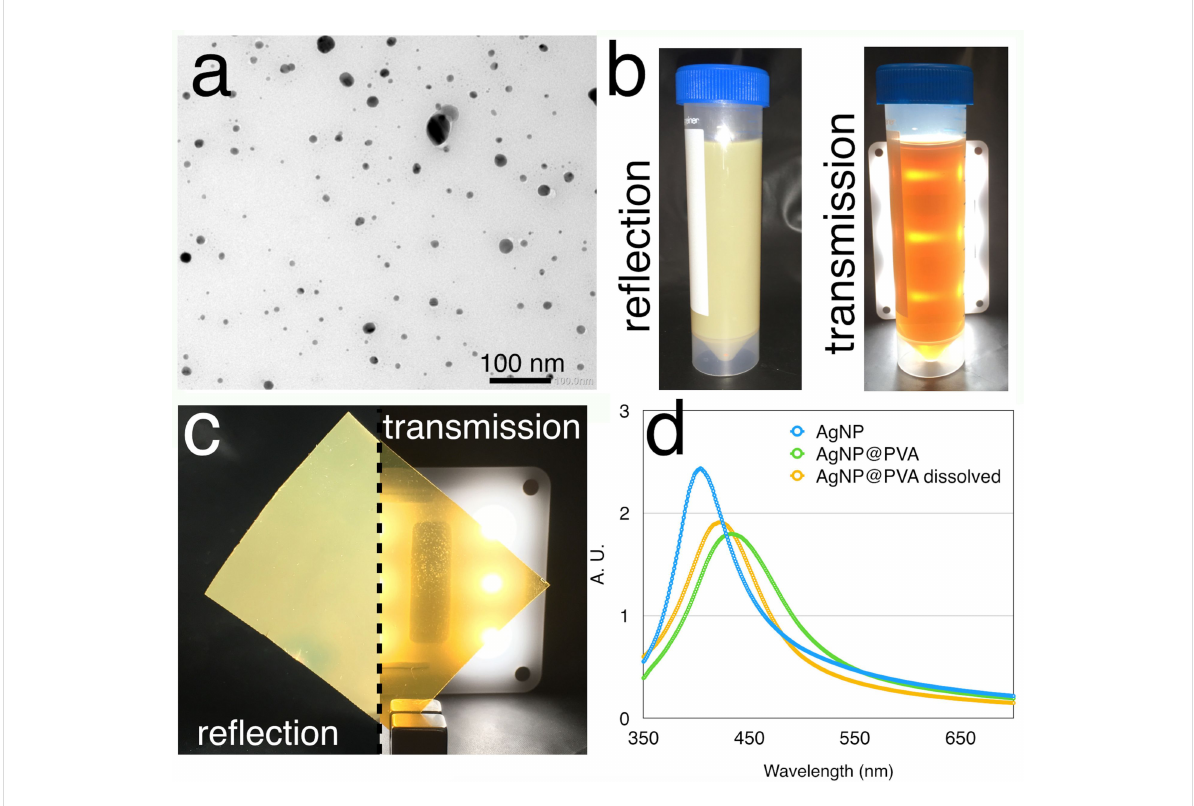
Figure 1: a) TEM picture of the dichroic AgNP solution; b) the AgNP solution shows the dichroic effect presenting a greenish colour when illuminated from the front and a yellowish/orange colour when illuminated from behind. c) when the nanoparticles are embedded in PVA, the nanocomposite ma- terial shows the same dichroic effect of the bulk solution. d) UV–vis spectra of the AgNP in solution (blue), embedded in PVA (green) and after the AgNP@PVA has been redissolved in water (yellow).